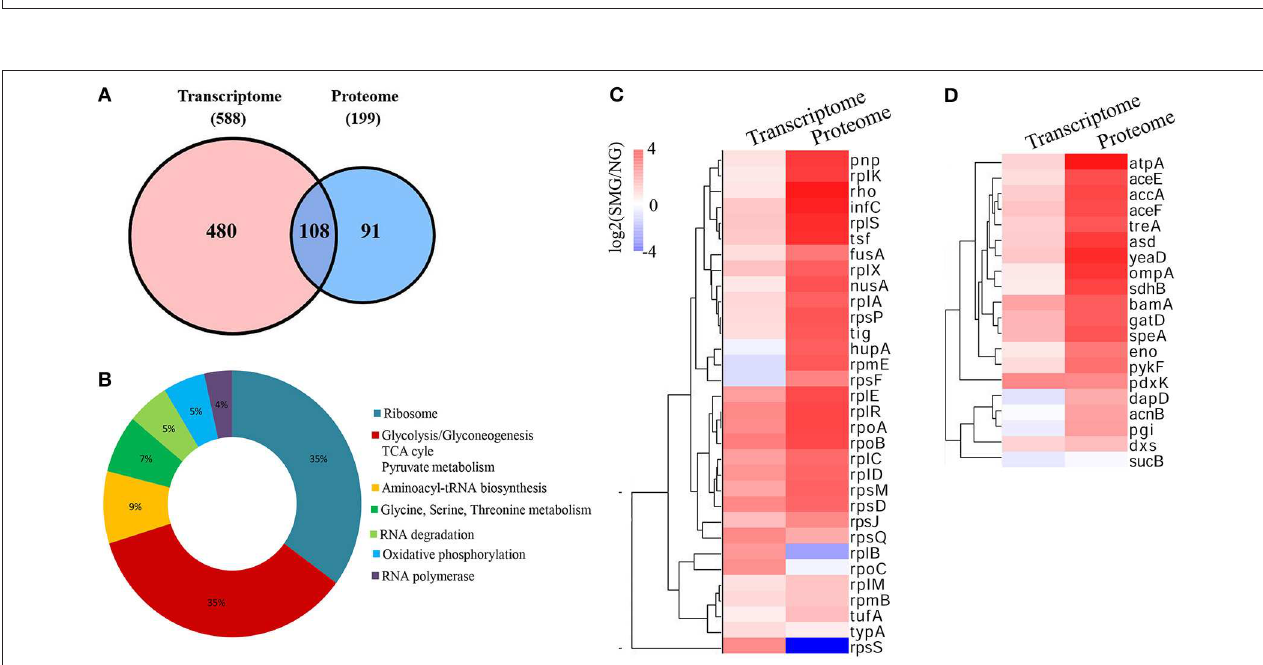
FIGURE 6 | Comprehensive comparison between transcriptomics and proteomics. (A) The intersection between transcriptome and proteome. (B) The clusters in the intersection. (C) Ribosome cluster in the intersection. (D) Carbon metabolism cluster in the intersection.